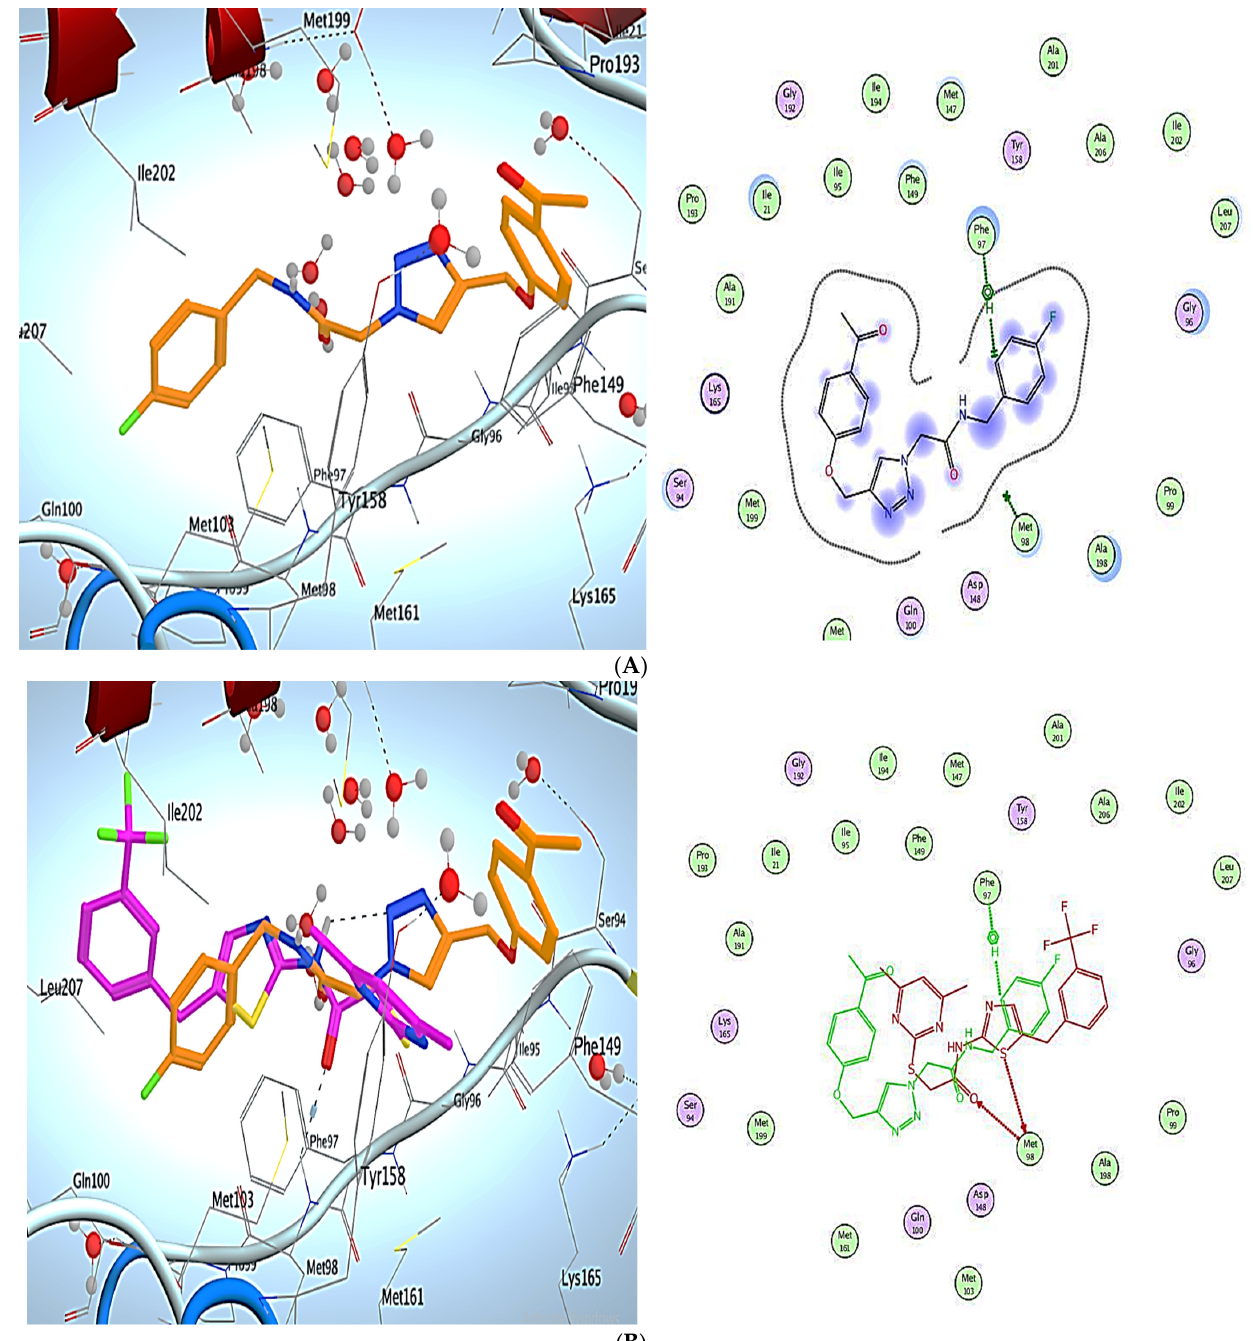
Figure 9. ( A ): Docking and binding pattern of compound 12 into InhA active site (PDB ID: 4UVD) in 2D (right panel) and 3D (left panel). ( B ): An overlay of the docked pose of compound 12 (brown) with the co-crystallized ligand (purple) into InhA active site in 2D (right panel) and 3D (left panel).